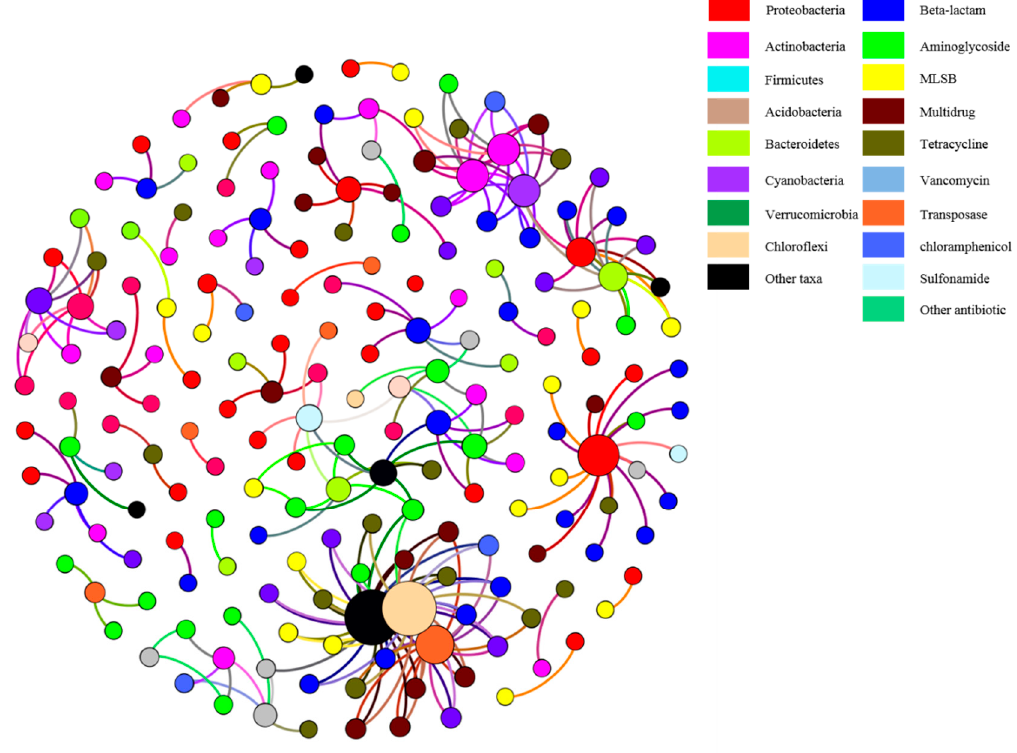
Figure 8. The co-occurrence patterns among ARGs and microbial taxa. The nodes were colored according to ARG types and genus. The size of each node is proportional to the number of connections, and the thickness of each connection between two nodes is proportional to the value of Spearman’s rank correlation coefficients ρ > 0.7. MLSB: macrolide–lincosamide–streptogramin B